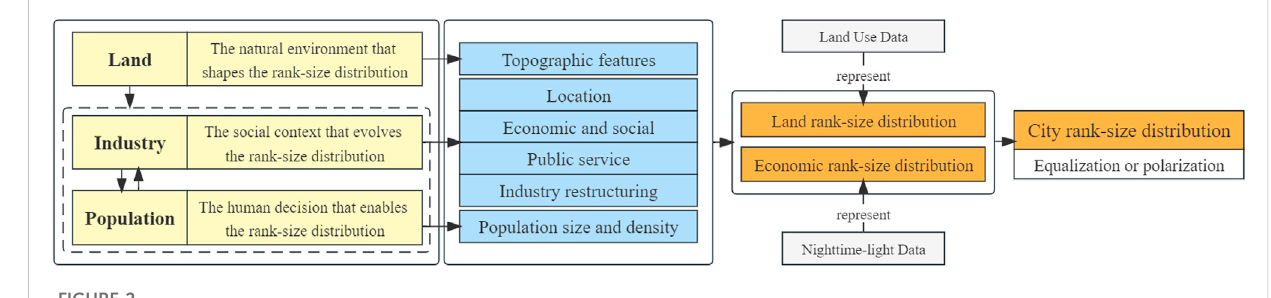
FIGURE 2 The evolution mechanism of intra city-size distribution.